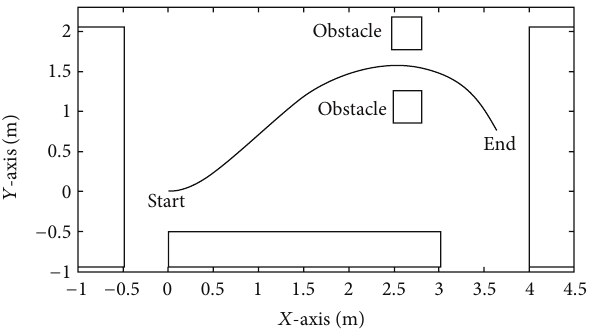
Figure 10: Path described by the wheelchair commanded by the linear and angular velocities of Figure